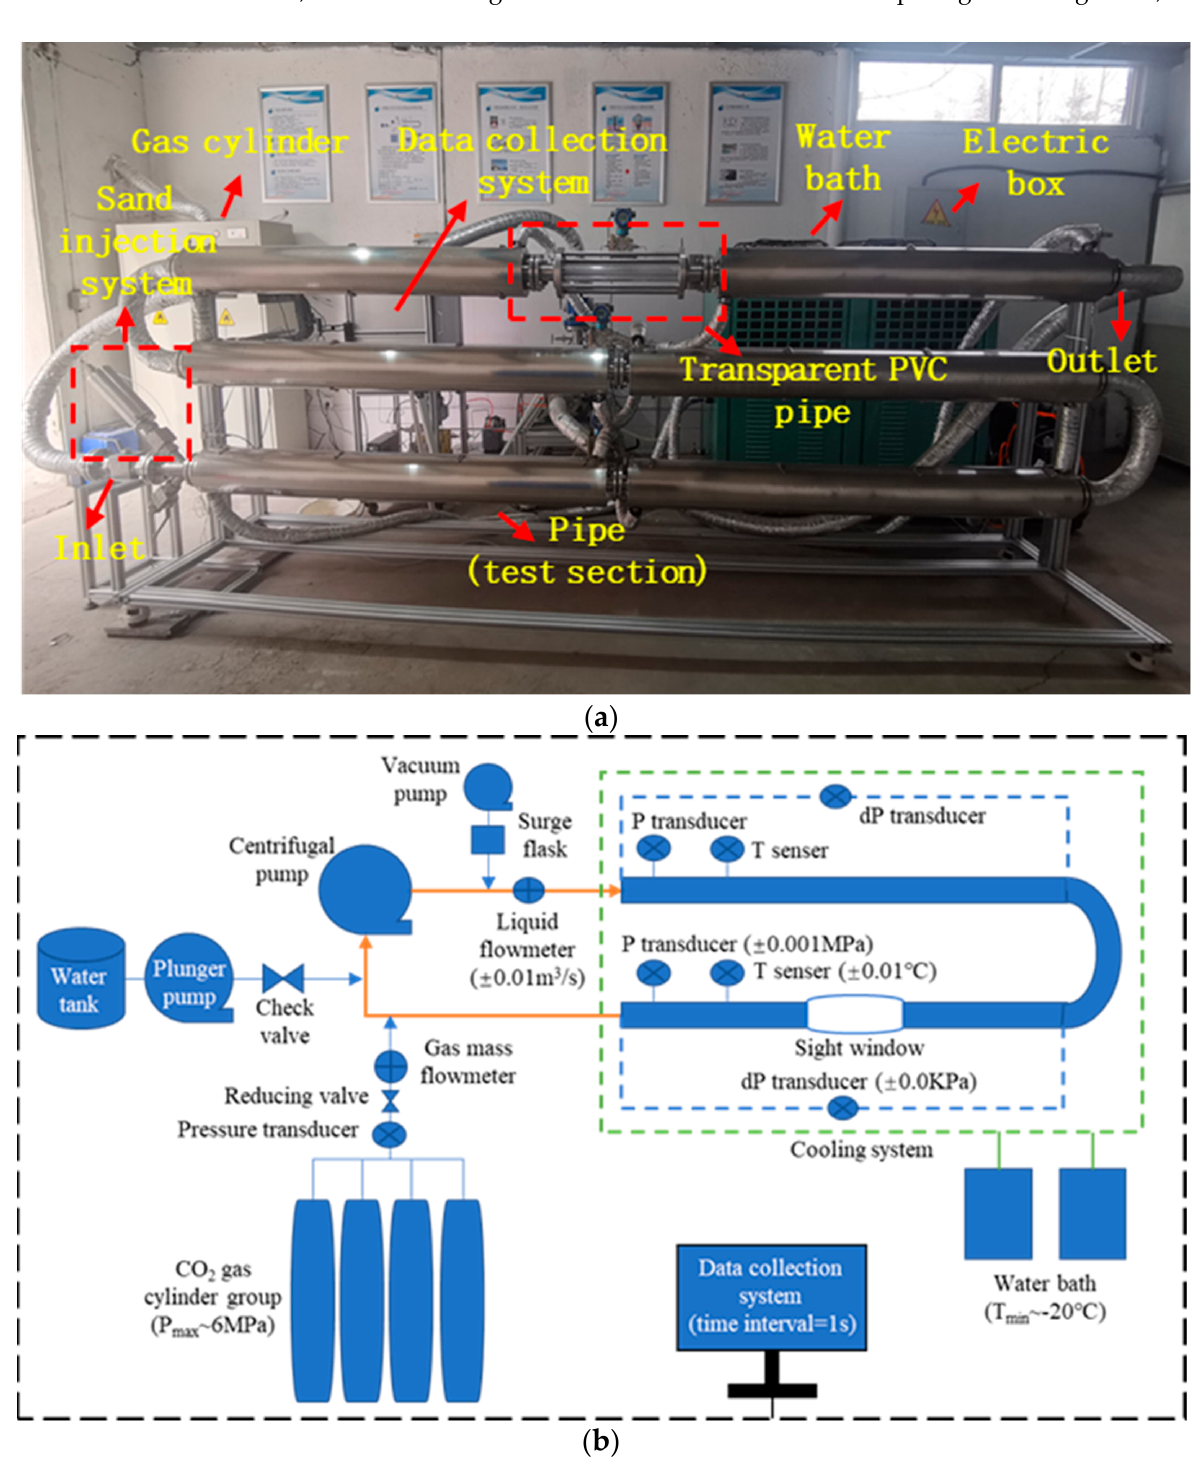
Figure 1. Introduction of high-pressure and low-pressure multiphase flow loop. ( a ) Image of flow loop. ( b ) Schematic of flow loop.